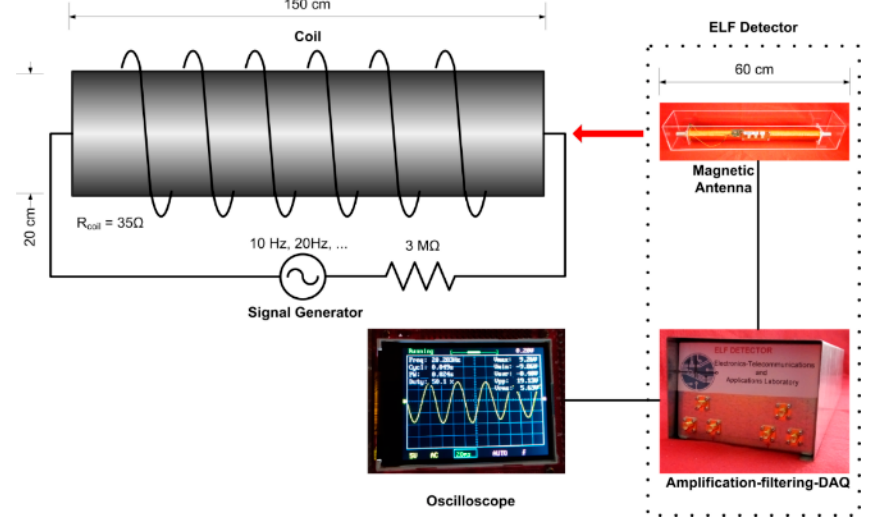
Figure 1. The entire test fixture consists of the coil, the signal generator, and the oscilloscope with the extremely low frequency (ELF) detector to be